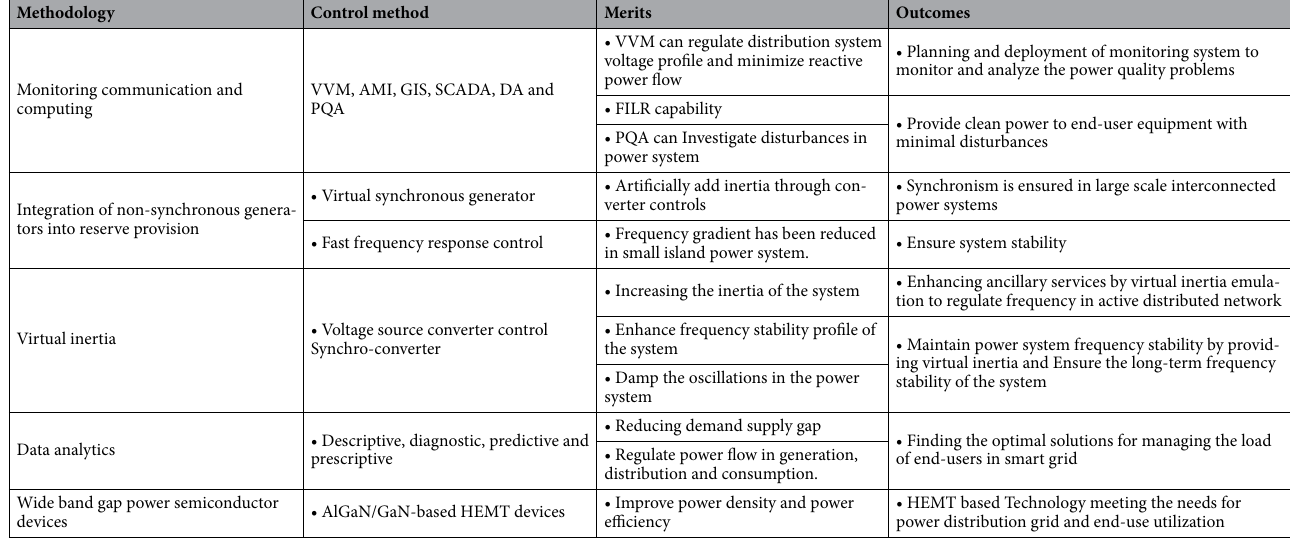
Table 3. Smart grid stability and